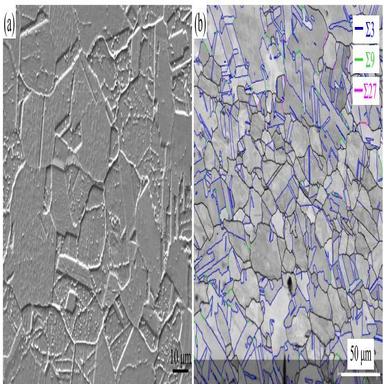
(a) SEM image distribution of carbides in the IN600 and (b) EBSD grain maps of boundary distribution in as-received condition. The color indicates different types of boundaries.